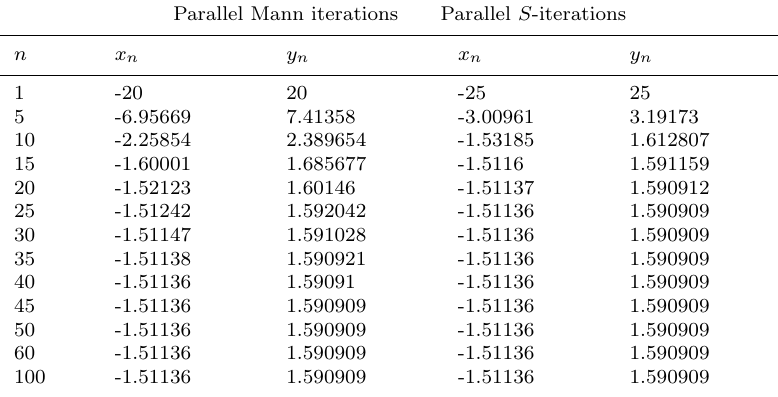
Convergence of parallel Mann iterative method (3.13) and parallel S -iterative method